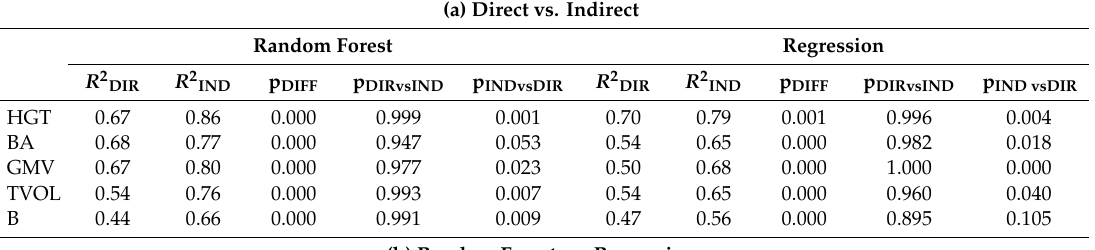
Table 5. Vuong test comparing observed versus predicted values from (a) the direct and indirect approaches and (b) random forest and regression models. (a) Direct vs. Indirect Random Forest